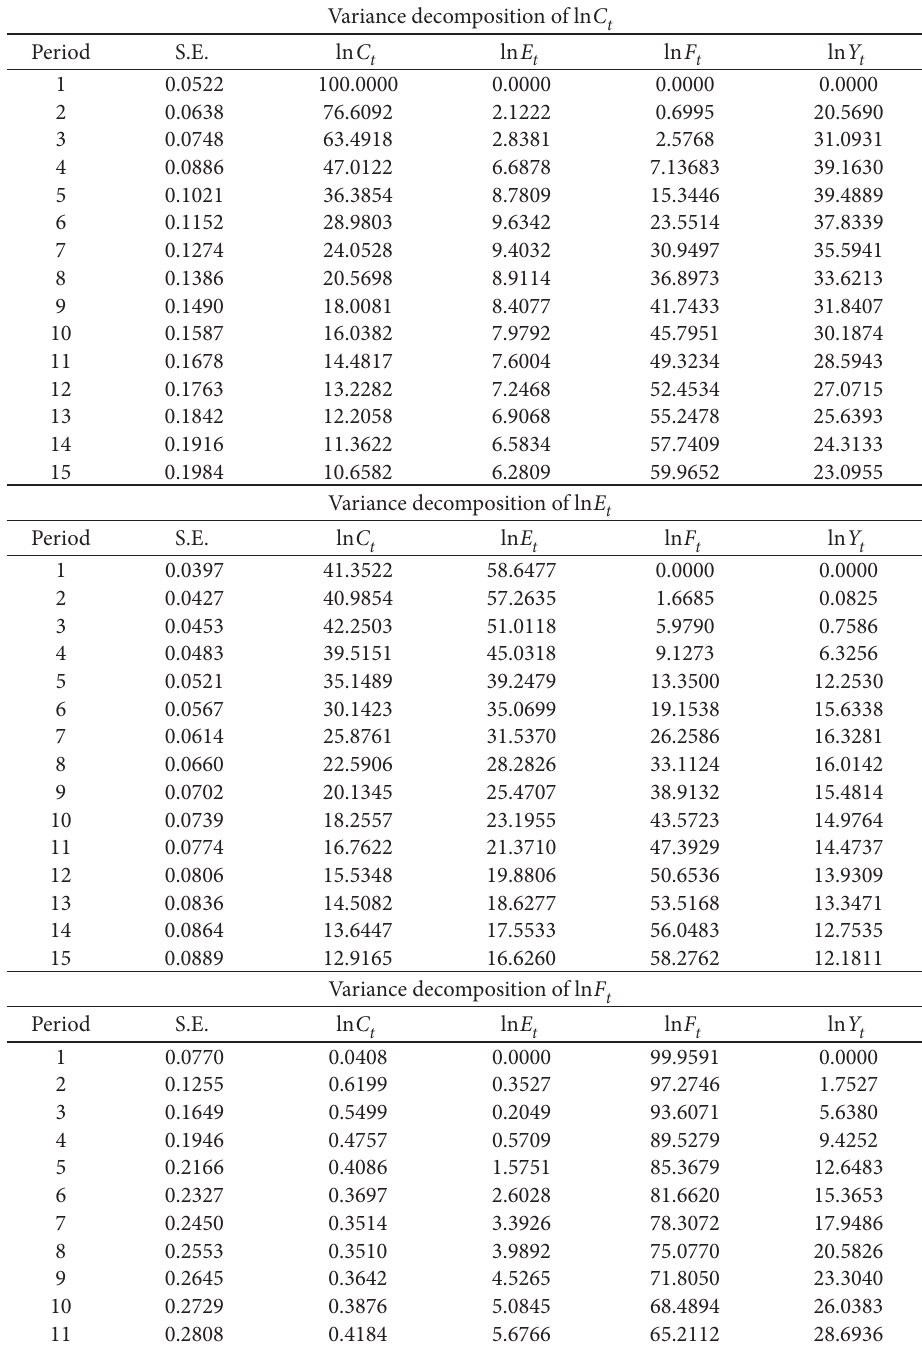
Table 6. Variance decomposition approach Variance decomposition of ln C